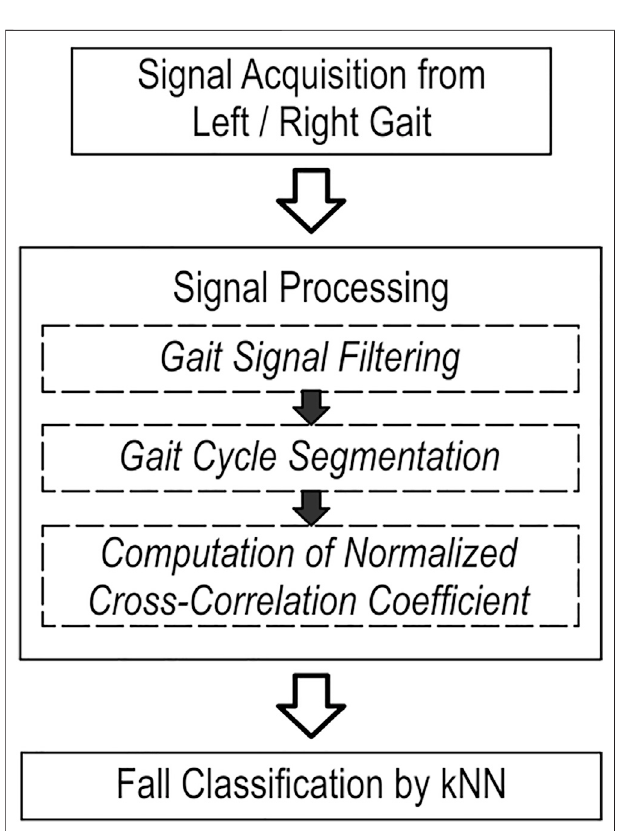
FIGURE 3 | Working procedure for gait signal data acquisition, processing, and classi fi cation. kNN, k-nearest